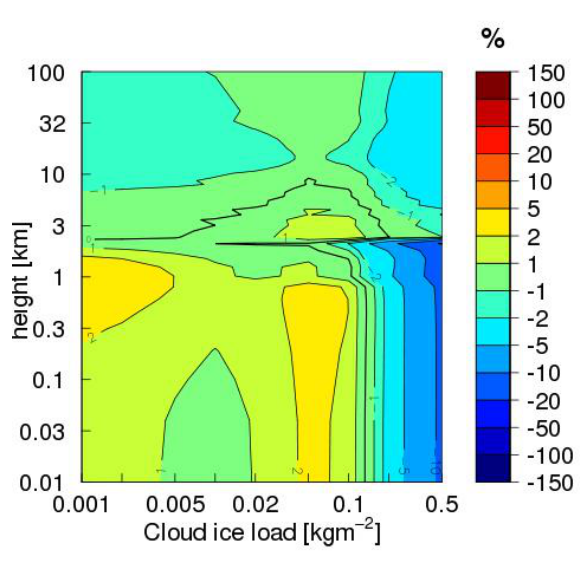
Figure 27. As for Fig. 26 but for the IFS radiation scheme using the Fu (1996) ice cloud optical property parameterisation vs. Fu-